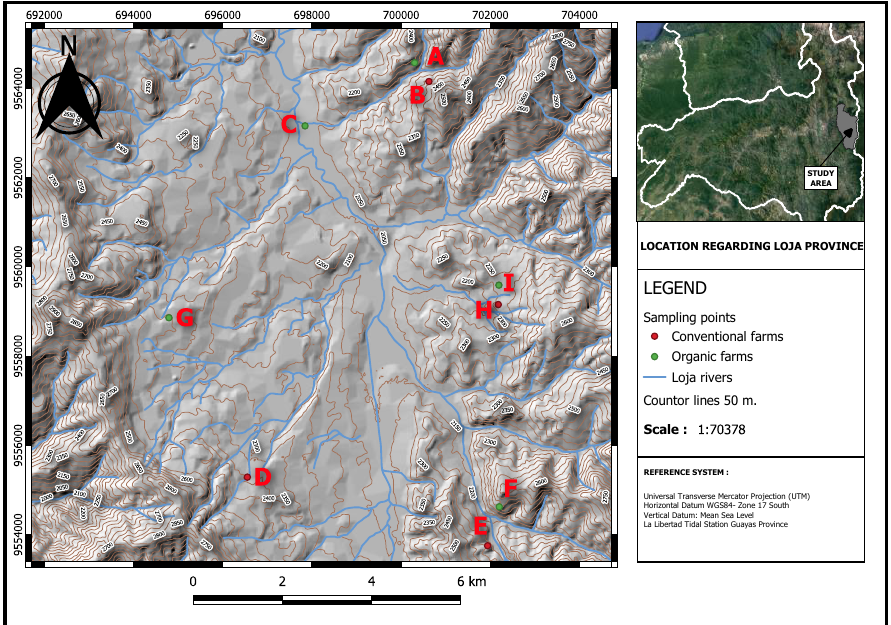
Figure 1. Location of the sampling zones in the basin of Loja city. (A, B) Shucos